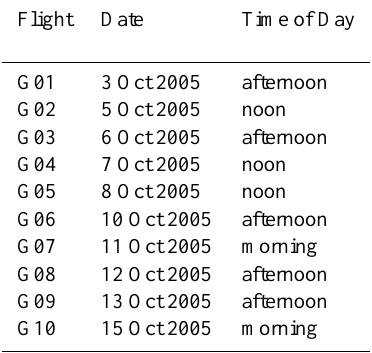
Table 1. Overview of flights performed during